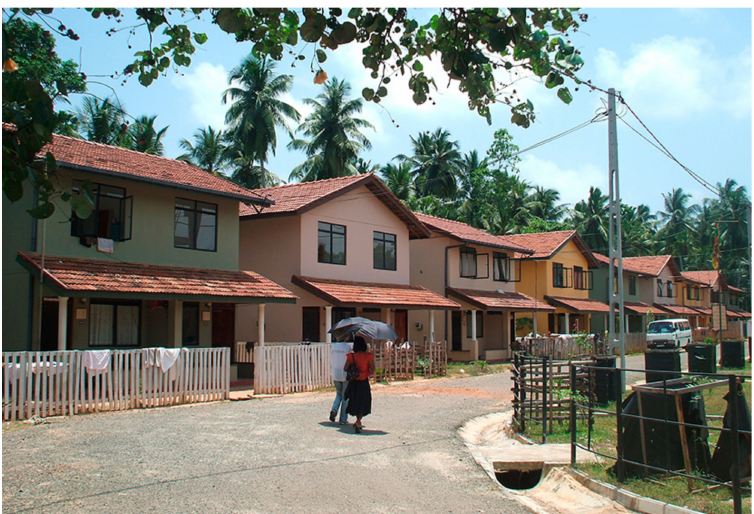
Figure 2. Two-storey duplexes in the Victoria Gardens project, Seenigama (source: Iftekhar Ahmed, University of Newcastle,